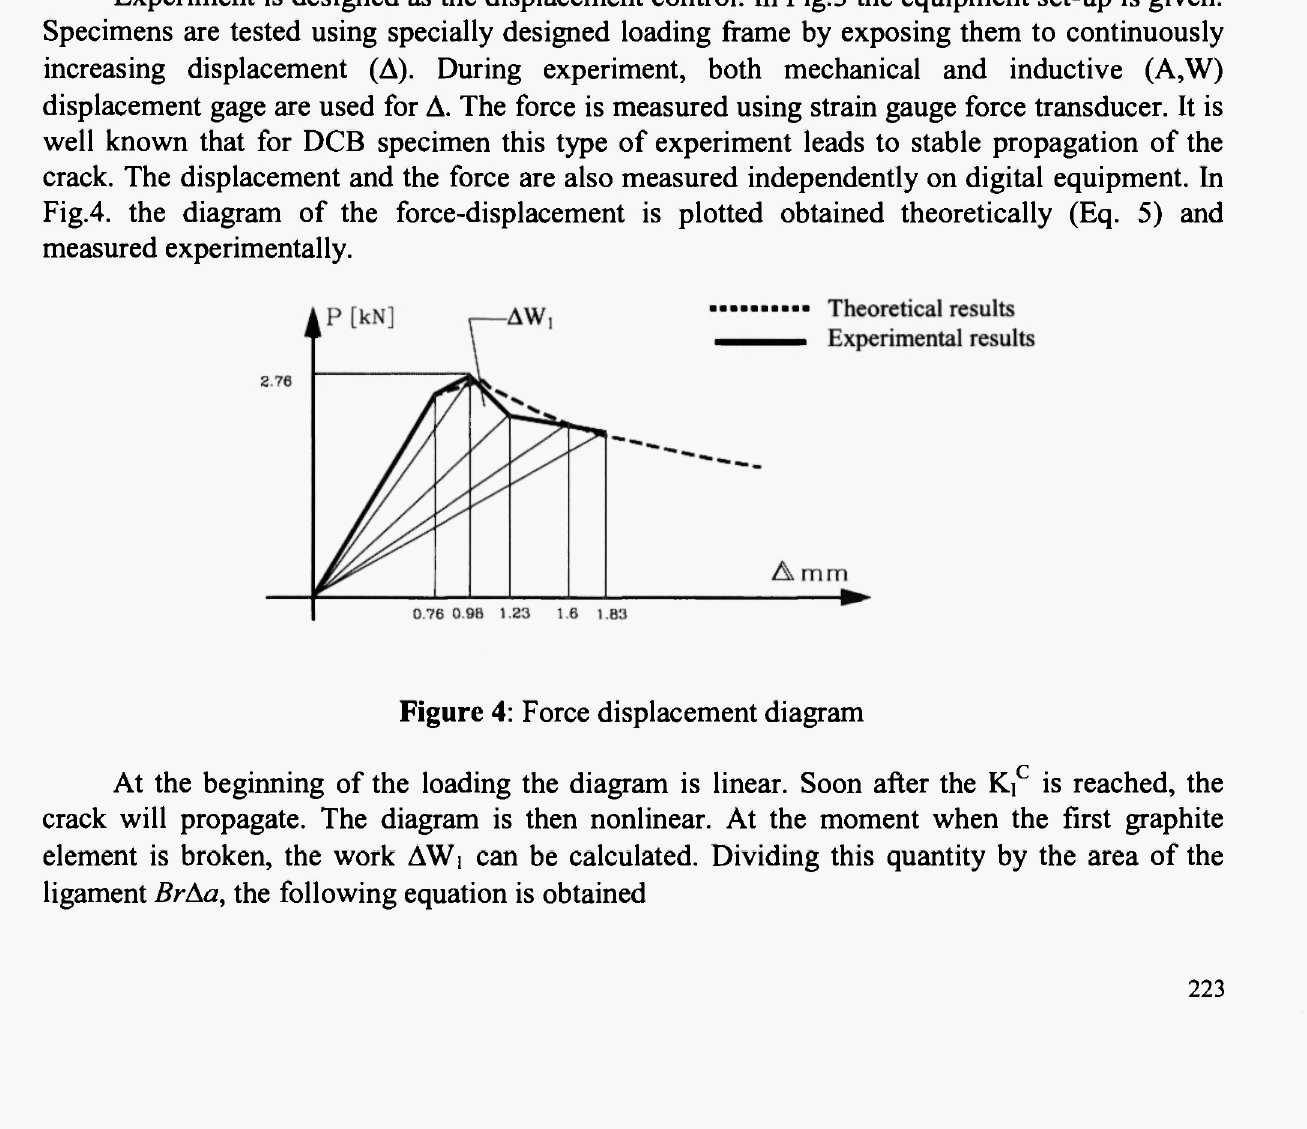
Figure 4: Force displacement